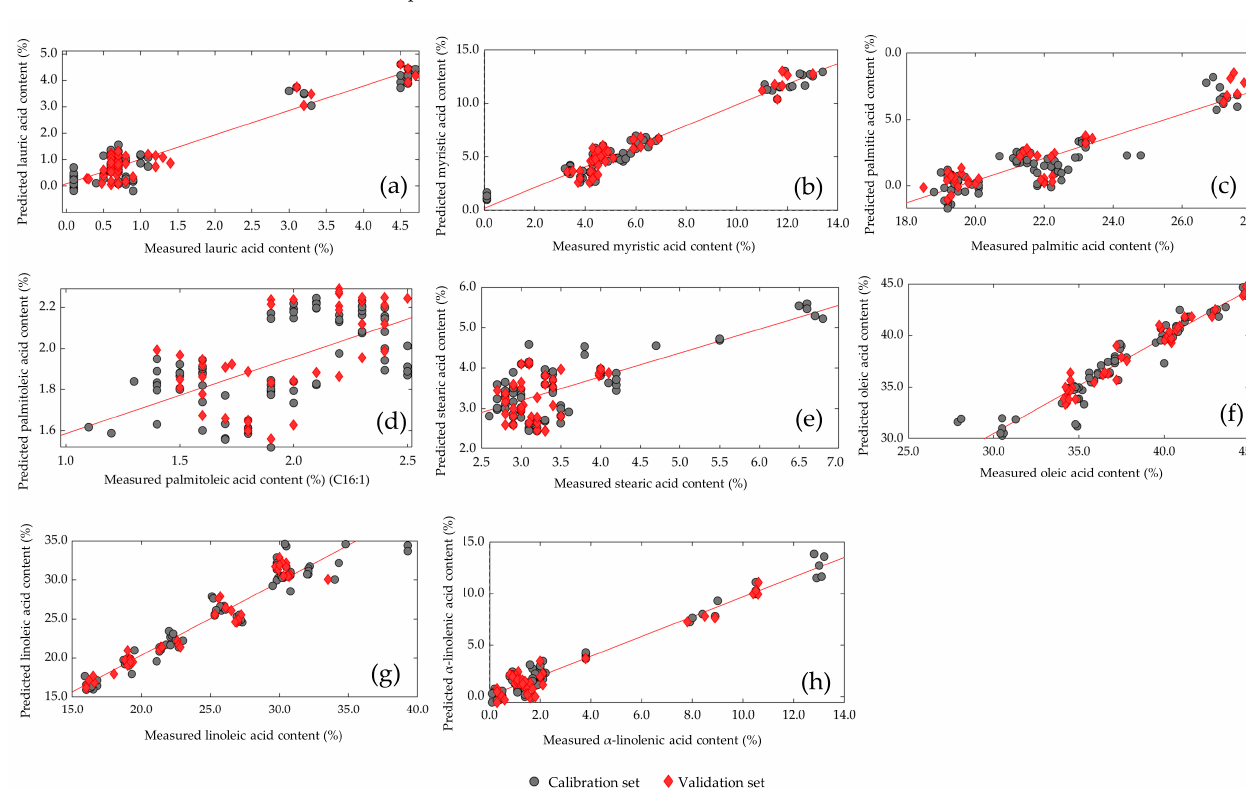
Figure 5. Comparison of the measured and predicted values of ( a ) lauric acid, ( b ) myristic acid, ( c ) palmitic acid, ( d ) palmitoleic acid, ( e ) stearic acid, ( f ) oleic acid, ( g ) linoleic acid, and ( h ) α -linoleic acid of living mealworm larvae in the calibration (•) and validation sets ( ♦ ). The measurements and predictions for the chosen PLS models (Figure 6) were com- pared between SFA, MUFA, and PUFA. Based on the criteria described previously, the best model was selected due to a high RPD and R 2P , a low RMSEP, and a limited number of latent variables (<10). Detailed prediction models with individual values for SFA, MUFA, and PUFA of each feeding group are available in the Supplementary Materials (Figure S3). The analysis of statistical data indicated that the SFA, MUFA, and PUFA con- tent can be predicted in living Tenebrio molitor larvae (Table 6), but NIR models are more accurate when the raw spectra are mathematically preprocessed. The correlation coeffi- cients were 0.948 (R 2C ) and 0.942 (R 2P ) for SFA, 0.886 (R 2C ) and 0.903 (R 2P ) for MUFA, and 0.943 (R 2C ) and 0878 (R 2P ) for PUFA. The RPD values (3.03–4.26) observed are usable for routine analysis.